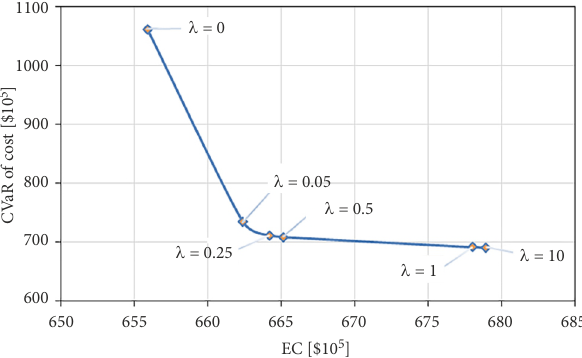
Figure 5. The optimal CVaR under different confidence levels for case